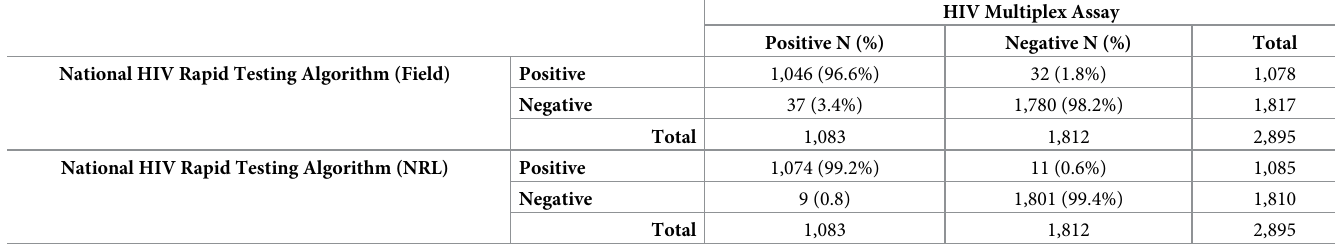
Table 6. Summary of the national serial HIV rapid testing algorithm compared with HIV multiplex assay